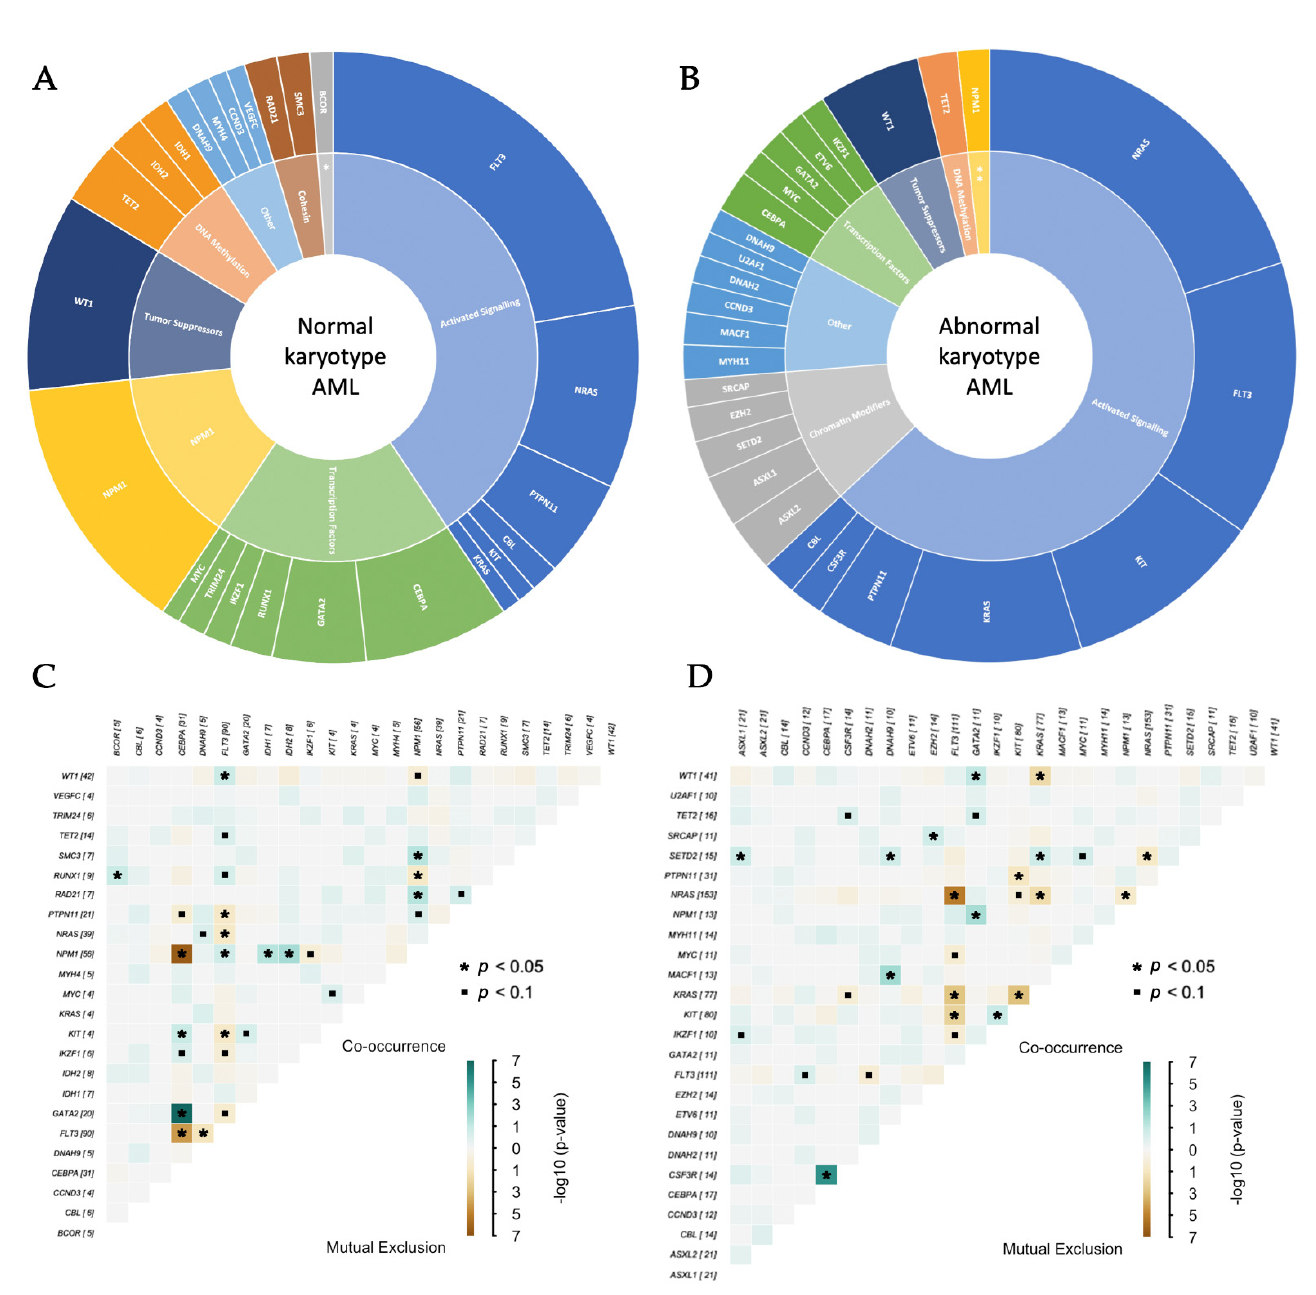
Figure 3. ( A , B ) The mutational landscapes of pediatric normal karyotype ( A ) vs abnormal karyotype ( B ) AML. ( C , D ) Co-occurrence and mutual exclusion of mutations in commonly altered genes of pediatric normal karyotype ( C ) vs abnormal karyotype ( D ) AML. The panels include genes mutated in ≥ 2% of samples within the respective groups. * Chromatin modifiers; ** NPM1